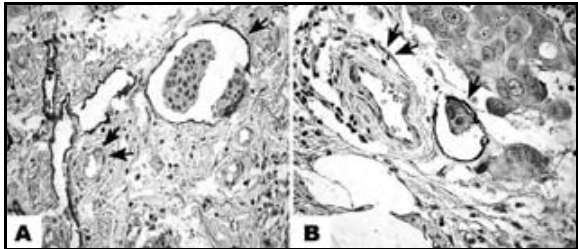
Figure – A and B show lymphatic vessels containing tumor emboli with endothelium positive for D2-40 (arrow), adjacent to blood vessels with endothelium negative